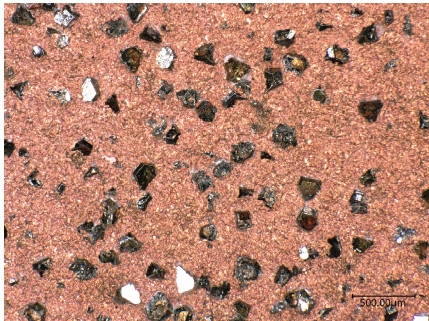
Figure 1: Microscopy image of CuCD RHP3434, with diamond particles dispersed in a copper